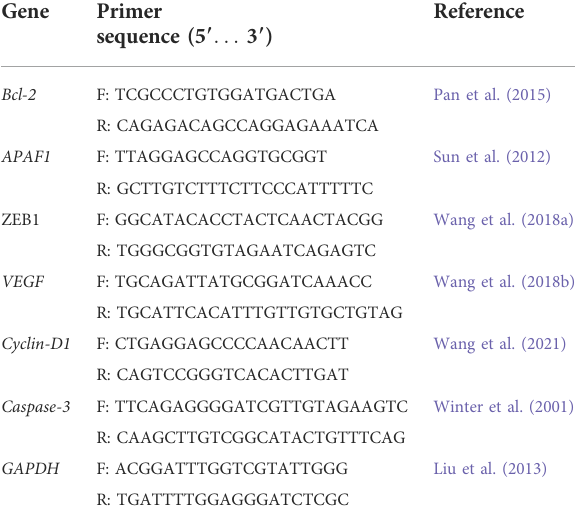
TABLE 1 Sequences of used primers for the ampli fi cation reaction.